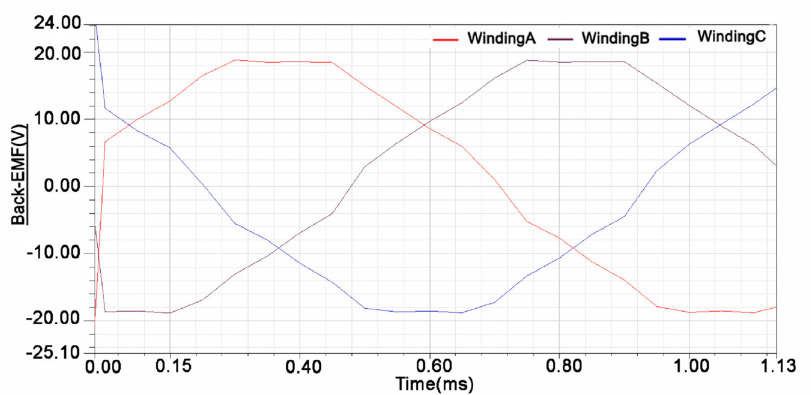
Figure 19. The no load back-EMF of the IPMBLDC